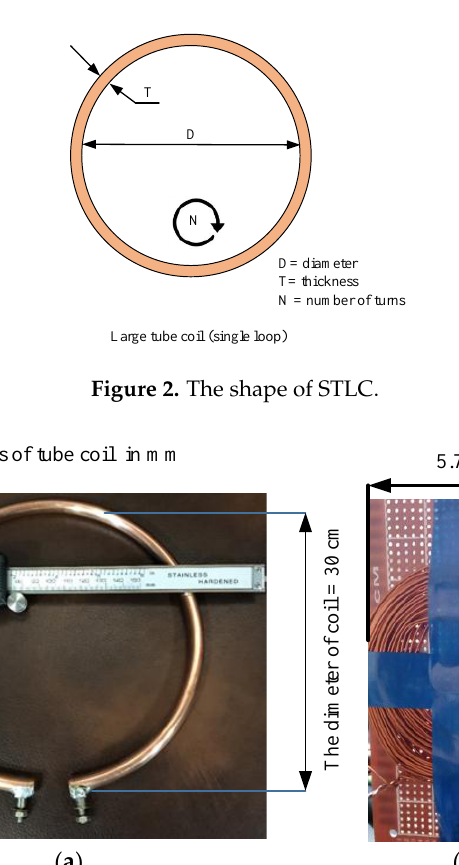
Figure 3. ( a ) Example of STLC and ( b ) MTCWC design.